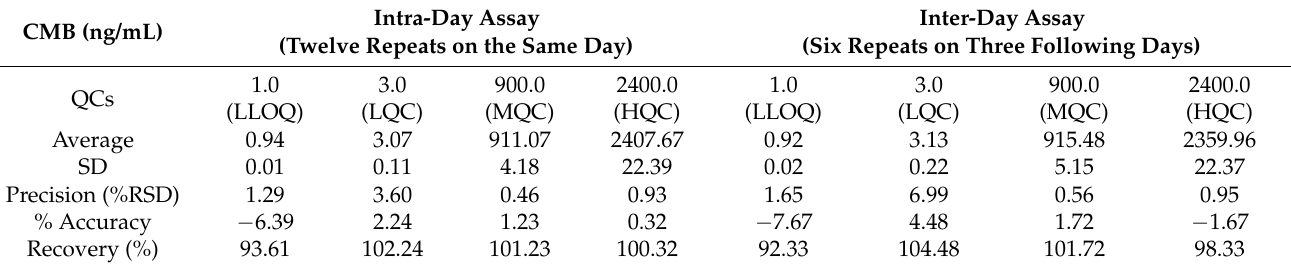
Table 5. Accuracy and precision of the developed UPLC-MS/MS chromatographic method.